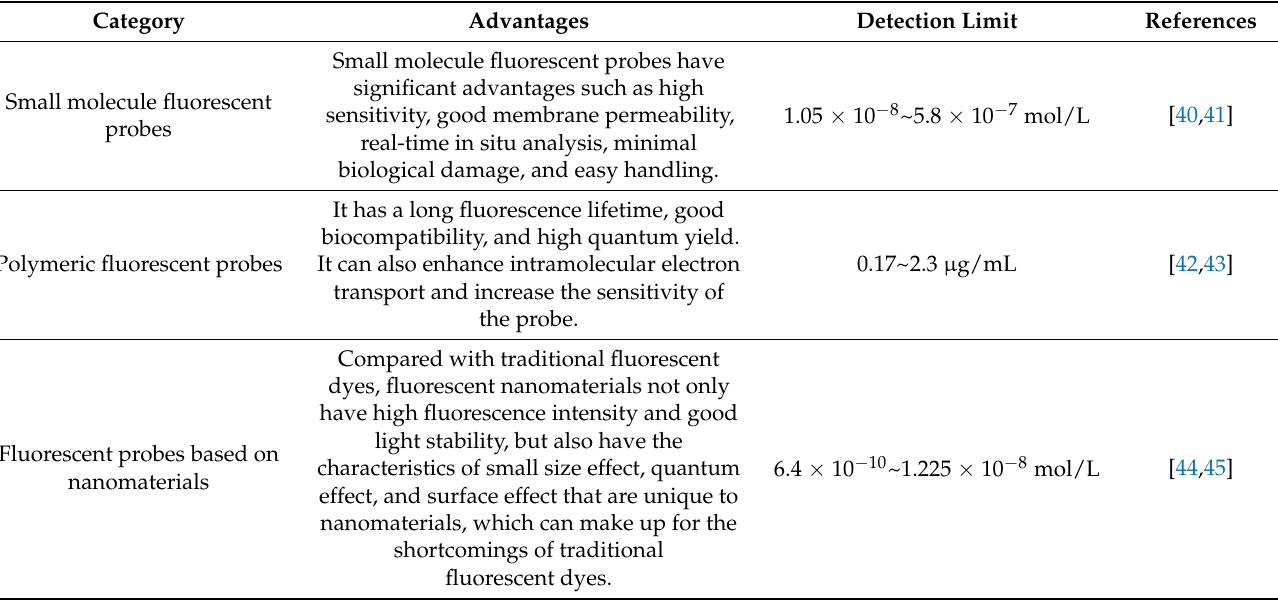
Table 1. Comparison table of fluorescent probes.